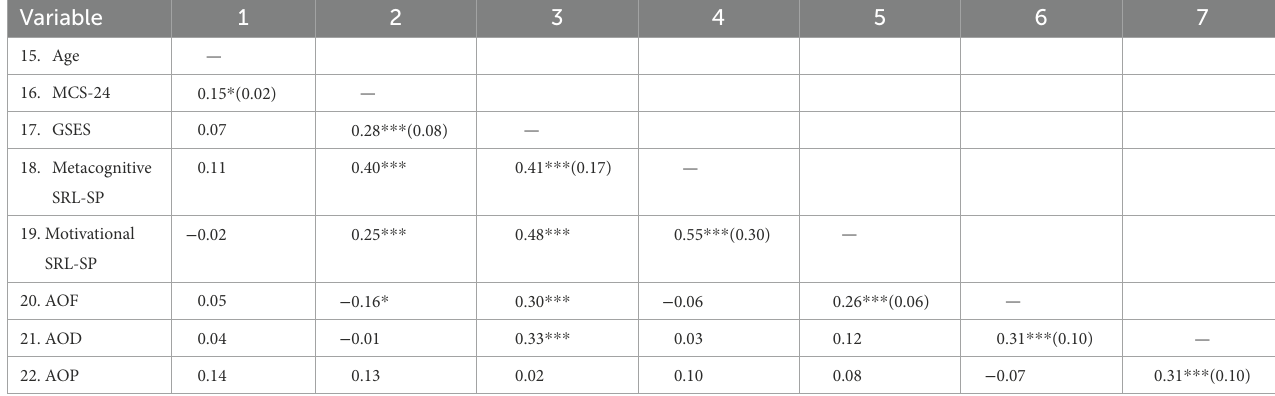
TABLE 3 Spearman rho correlations between age, the short form SRL-SP subscales, and measures of metacognitive self, general self-efficacy, and action- control subscales.